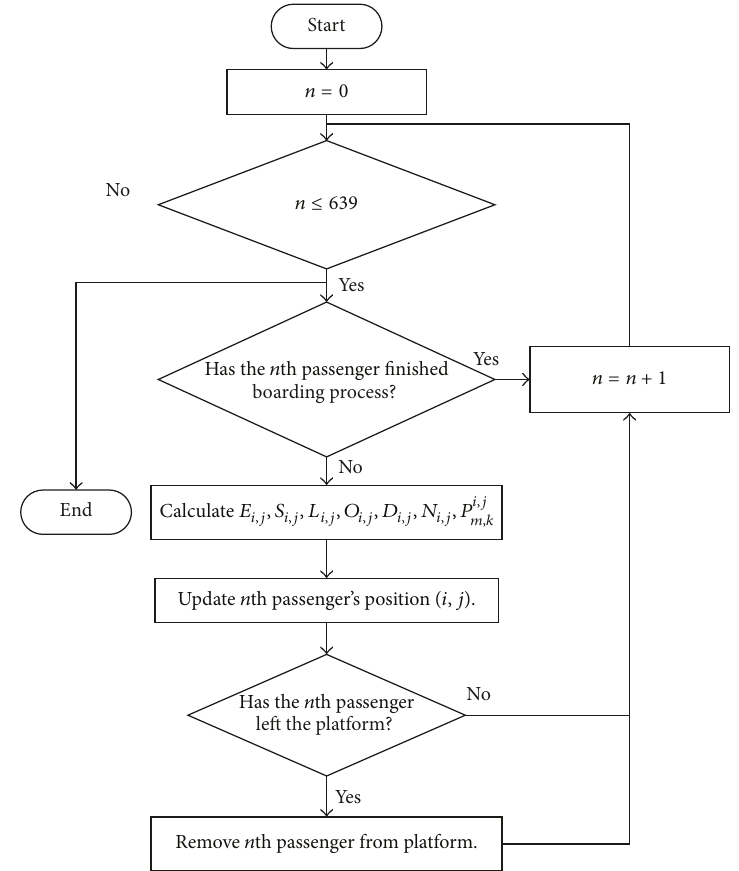
Figure 3: The flow chart of update rules at each time